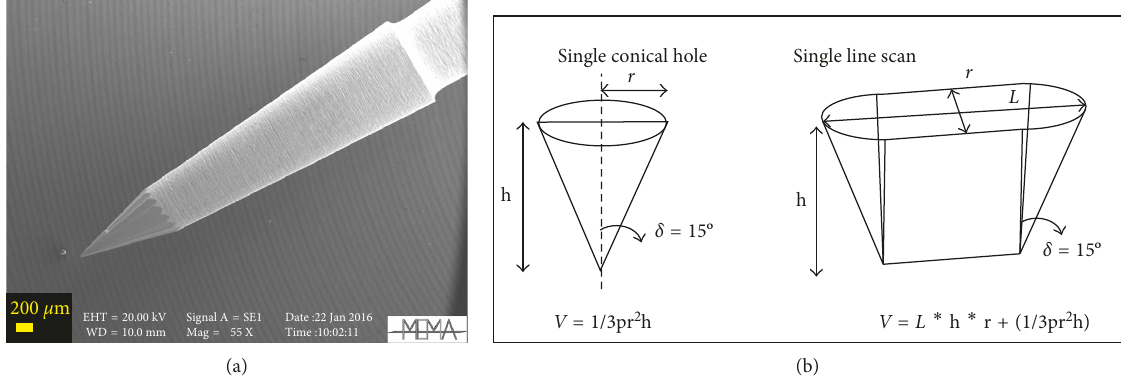
Figure 3: (a) SEM imaging of a tungsten carbide drill bit used for milling: the tip angle is 30 ° and geometrical shape of (b) a single conical hole and single line